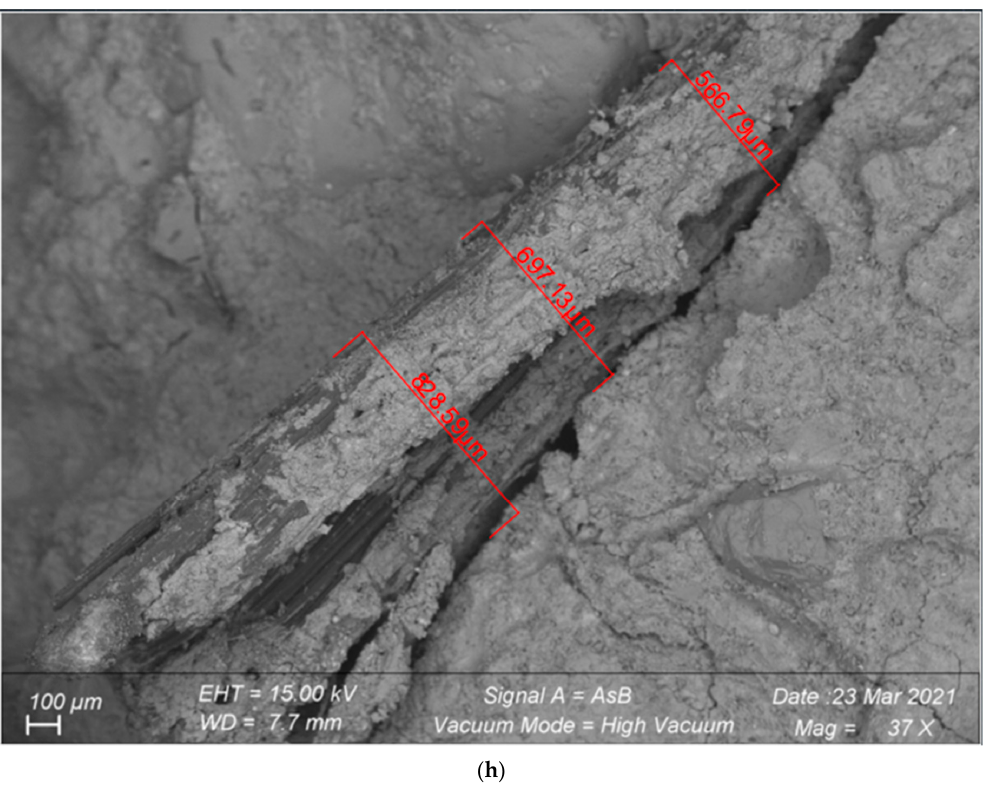
Figure 12. SEM images enabling an assessment of the distribution of the fibers and their relationships with the matrix taken by SEM in high vacuum mode: ( a ) Raw hemp fibers ( × 144–Zoom × 20). (b ) Hemp fibers in cement mortar (× 500–Zoom × 10). ( c ) Raw flax fibers (× 300–Zoom × 20). ( d ) Flax fibers in cement mortar (× 300–Zoom × 20). ( e ) Raw bamboo fibers (× 300–Zoom × 10). ( f ) Bamboo fibers in cement mortar (× 279–Zoom × 20). ( g ) Raw miscanthus fibers (× 140–Zoom × 30). ( h ) Mis-